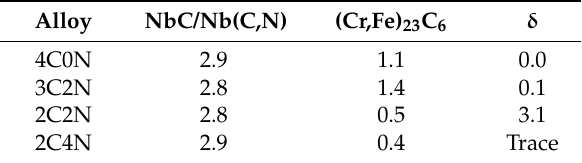
Table 2. Area fractions of precipitates in these alloys, measured by digital image-analysis